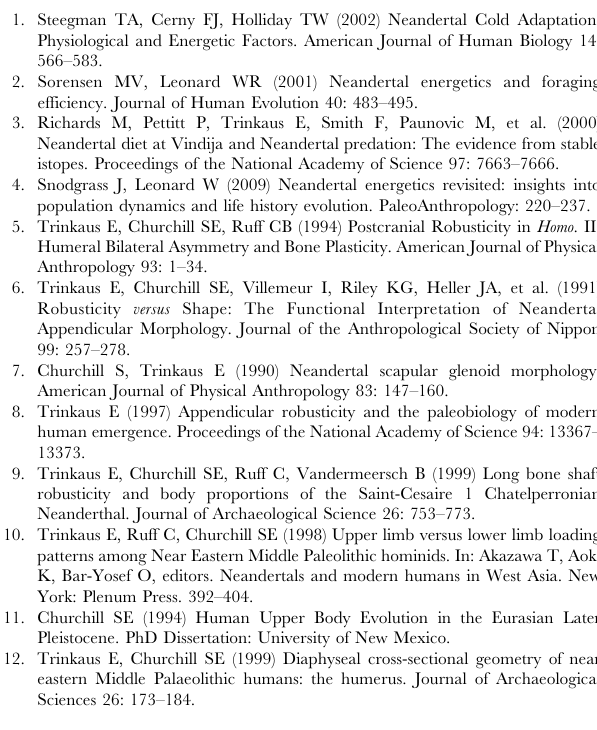
Figure S6 Replica side scrapers used for the push and pull scraping tasks. (TIF) Figure S7 Experimental setup for the push and pull scraping tasks. (TIF) Figure S8 Activity window definition; spearing tasks. Processed EMG patterns shown in black, with the final activity time windows shown in green. (TIF) Figure S9 Activity window definition; scraping tasks. Processed EMG patterns in black. Blue lines indicate local minima, determined from peak detection code, whereas green lines illustrate the activity bursts.